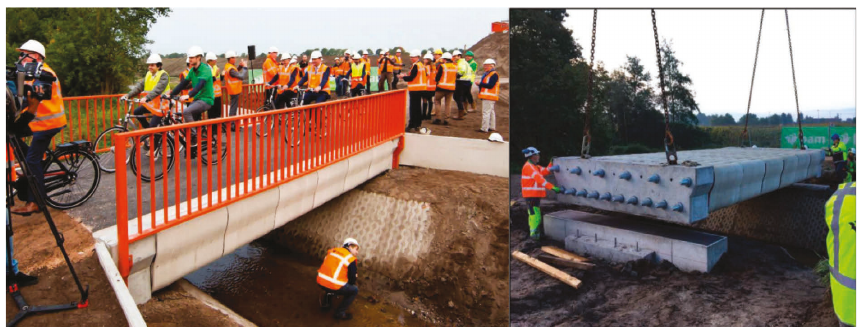
Figure 30: Installation process and overall structure of concrete 3D printing bridge [60].